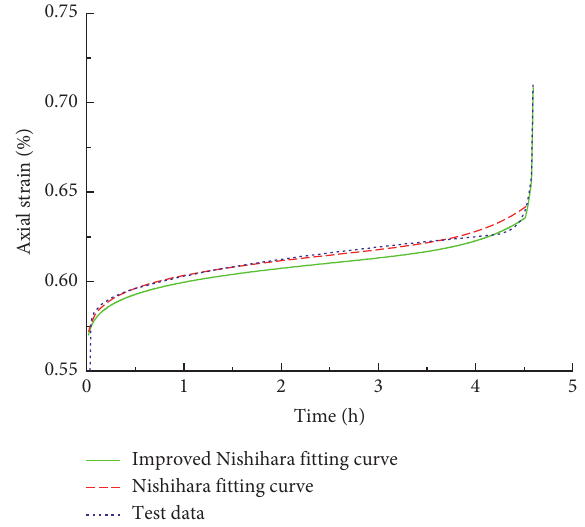
Figure 14: Comparison of accelerating creep curves and test curves of two creep